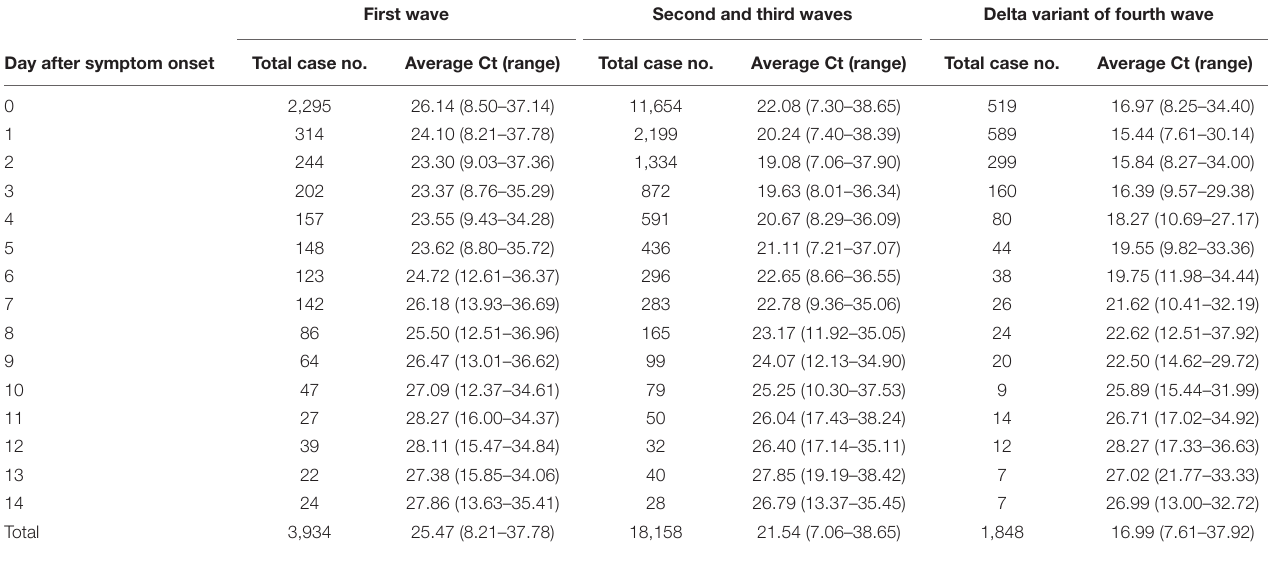
TABLE 3 | Daily average Ct value of COVID-19 cases from the day following onset of